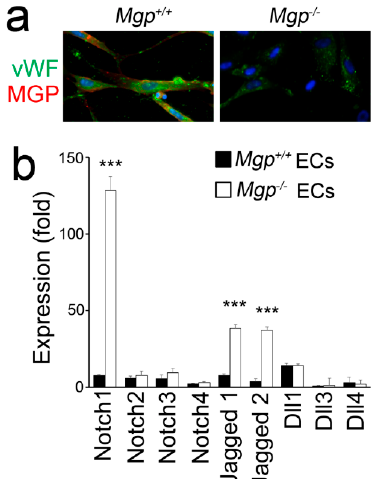
Figure 1. Increased Notch signaling in Mgp − / − cerebral endothelial cells (ECs). ( a ) Immunostaining of cerebral ECs isolated from wild-type ( Mgp +/+ ) and Mgp − / − mice. The cells were incubated for 24 hours to let them attach to the slides before staining; vWF, von Willebrand factor. ( b ) Expression of Notch receptors 1, 2, 3, and 4, and Notch ligands Jagged1 and 2 and Delta-like (Dll)1, 3, and 4 in cerebral ECs isolated from wild-type ( Mgp +/+ ) and Mgp − / − mice (n = 8), as determined by real-time PCR. *** p <